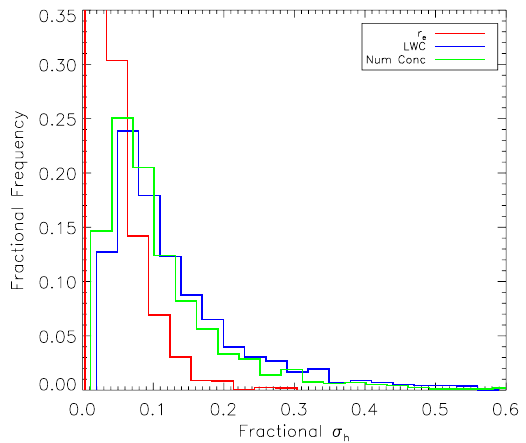
Fig. 2. Histogram of the fractional standard deviation of r e , LWC and number concentration measured during 280 5km long straight and flight level